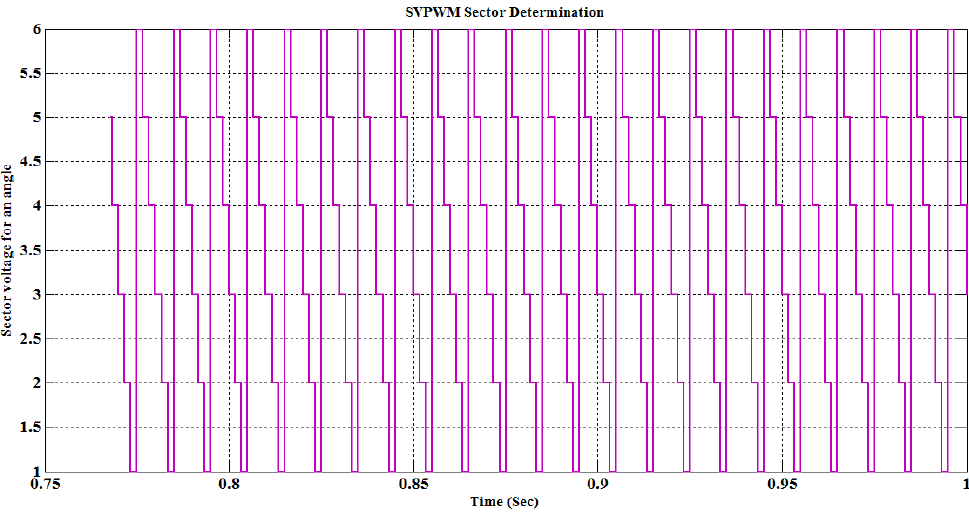
Figure 12. SVPWM Sector Determination.